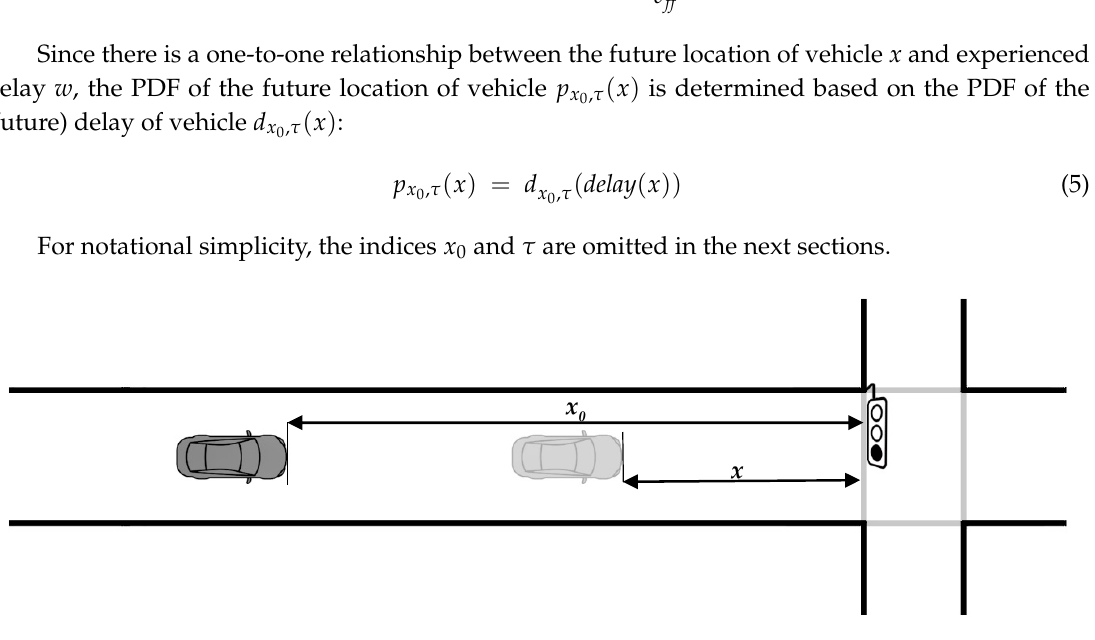
Figure 2. The distance between the vehicle and the downstream intersection is denoted by x .